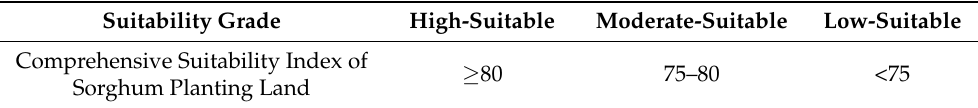
Table 4. Classification index of comprehensive suitable grade of sorghum planting